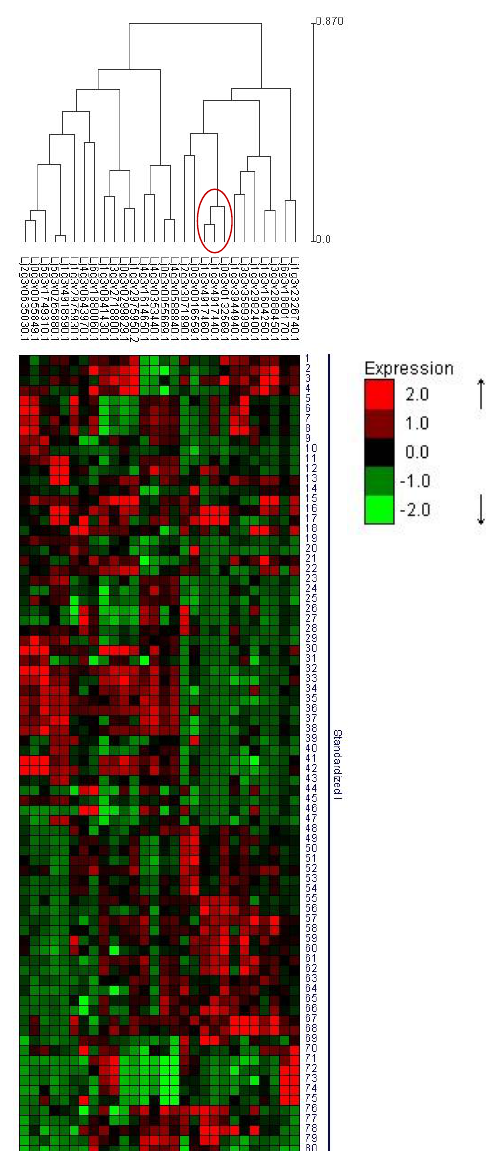
Figure 4. Hierarchical clustering of shoot DEGs. In the case of shoot, all of the DEGs (both up- or downregulated in Nod plants) were used for the clustering analysis. A red circle highlights the position in the clustering analysis of the three glutaredoxin isoforms identified in this work.